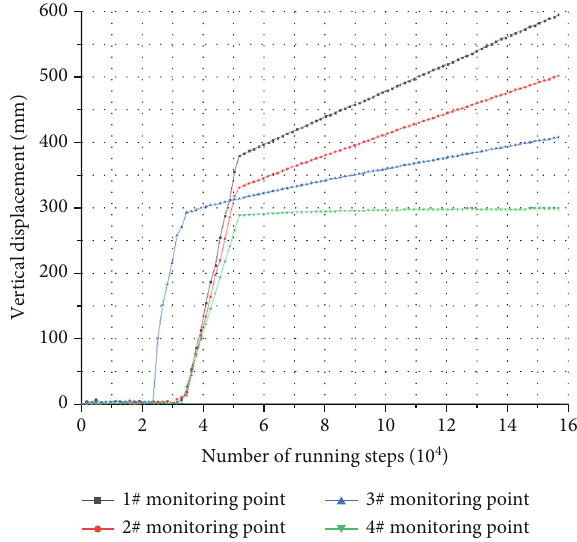
Figure 17: Vertical displacement change of slope monitoring point.